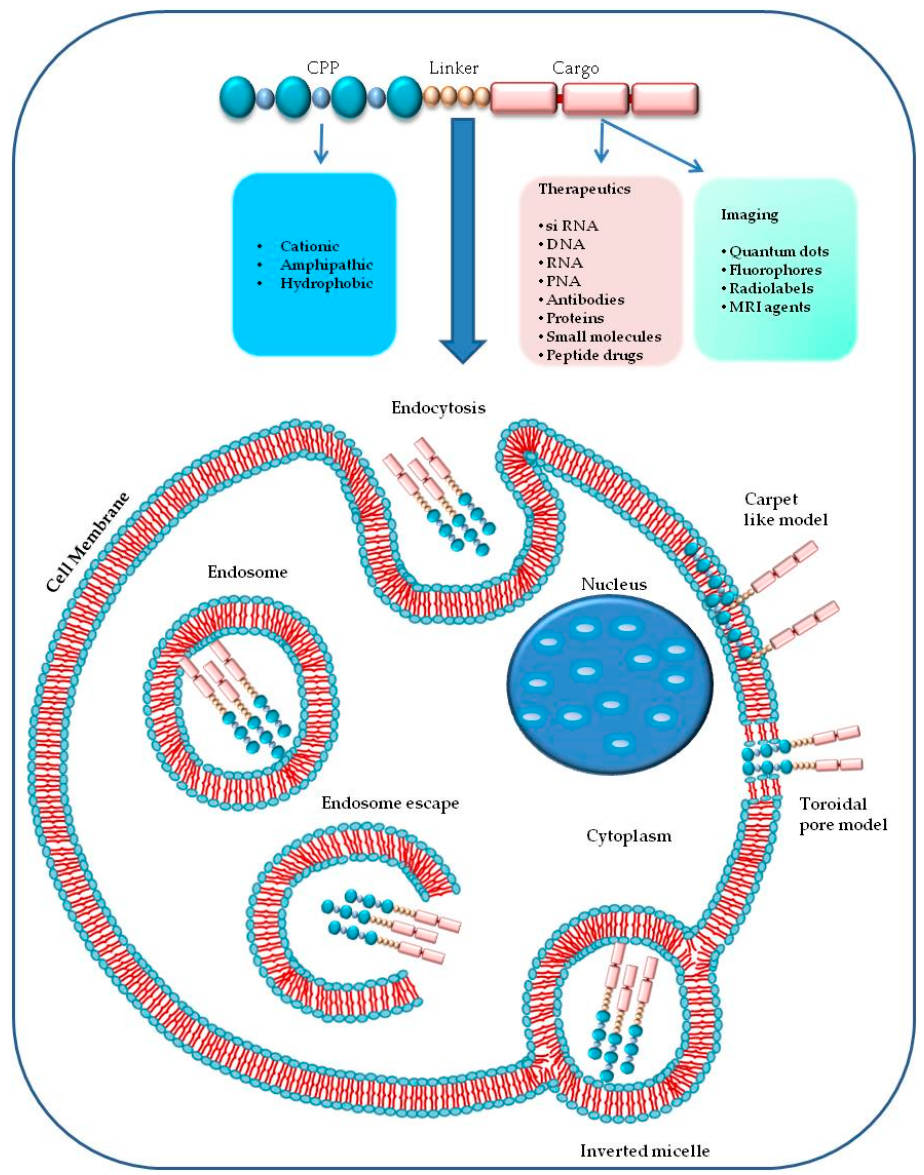
Figure 2. Schematic representation of several cargo types delivered by CPPs and of cellular uptake mechanisms including endocytosis (clathrin mediated endocytosis, caveolae mediated endocytosis, clathrin/caveolae indipendent) and direct traslocation (carpet like model, toroidal pore model).